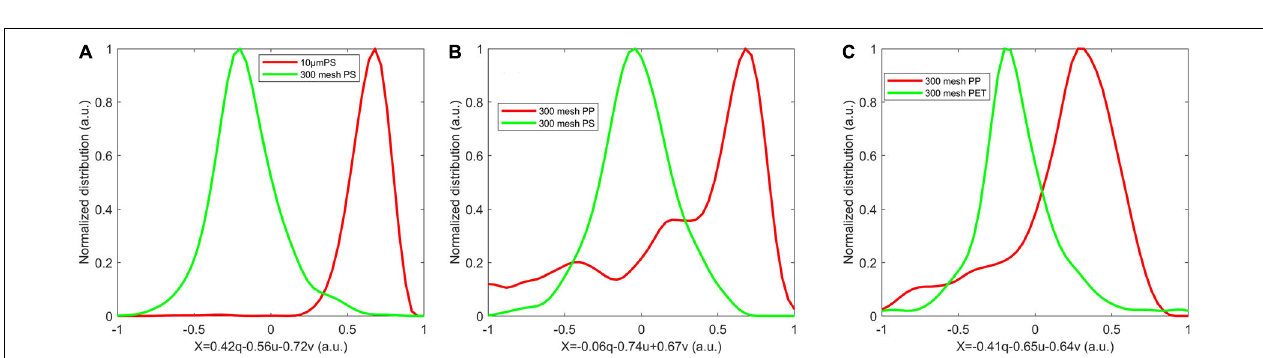
FIGURE 3 | Polarized linear discrimination analysis (LDA) distribution of microalgae and 10-micron spherical polystyrene (PS). (A) Separate experiment of Scenedesmus Obliquus (SO) and PS. (B) Mixed experiment of SO and different concentrations of PS. (C) Quantitative graph of PS with increasing concentration. (D) Adding SO, Prymnesium Parvum (PP), Haematococcus Pluvialis (HP), Scrippsiella Trochoidea (ST), Phaeodactylum Tricornutum (PT), Chlorella Vulgaris (CV), and Cyanobacteria (CB) in sequence to 1 mg/L PS.